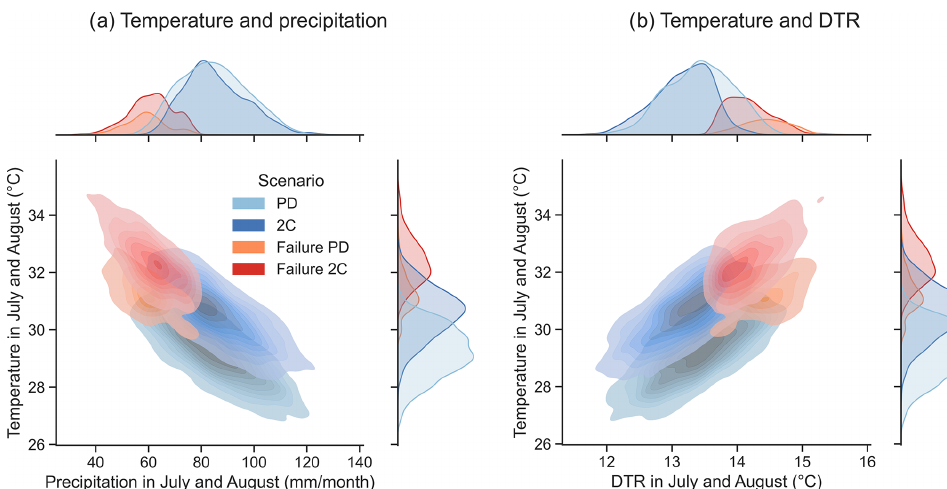
Figure C8. Same as Fig. 7 but for the 2C scenario.